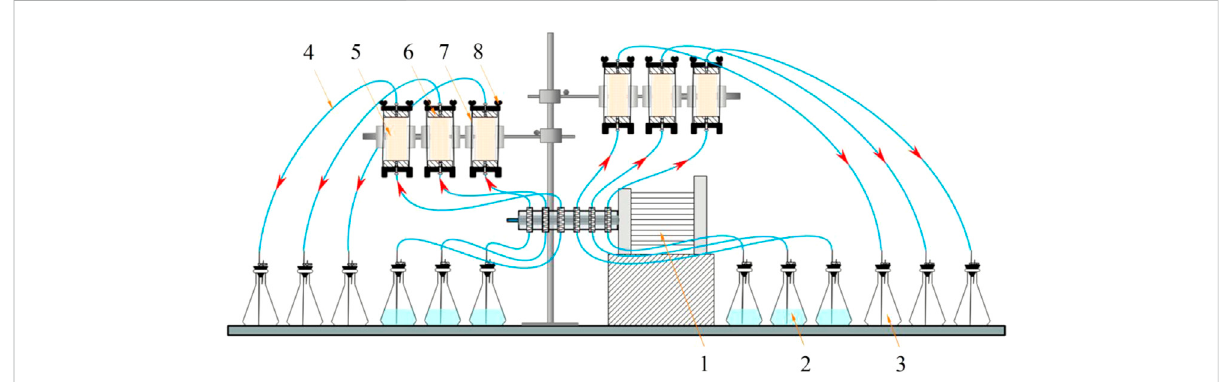
FIGURE 3 Schematic diagram of grouting: 1. Peristaltic pump; 2. Treatment solution; 3. Waste liquid bottle; 4. Silicone tube; 5. Sand column; 6. Tube cap; 7. Fixed bracket; 8. Butter fl y nut.